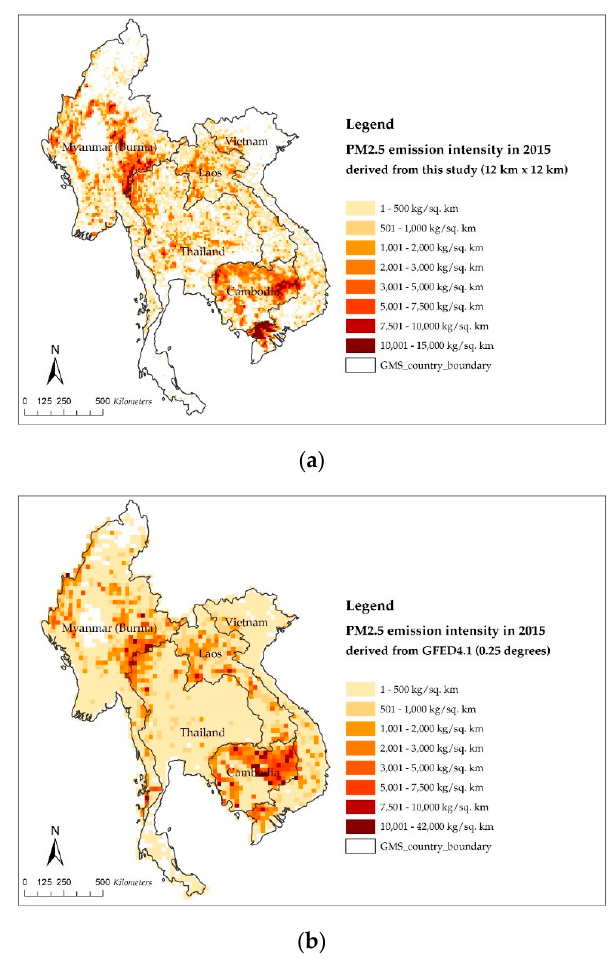
Figure 7. Comparison of the intensity of the PM2.5 emissions from the biomass open burning in the GMS between ( a ) this study and ( b ) the GFED4.1s in 2015.